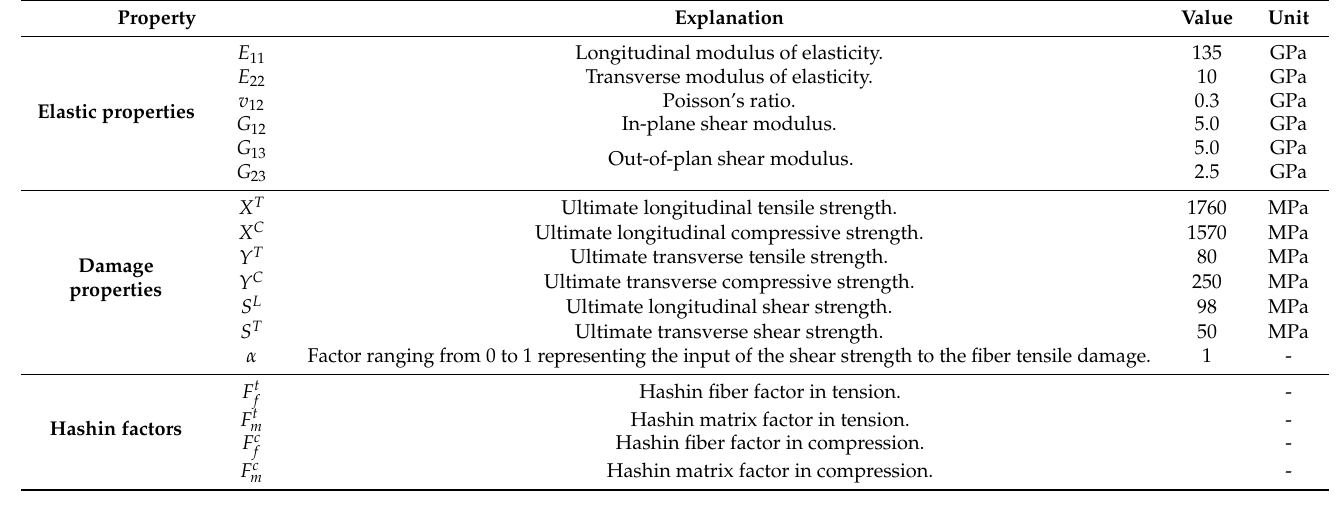
Table 4. Properties of the material used in the numerical model.